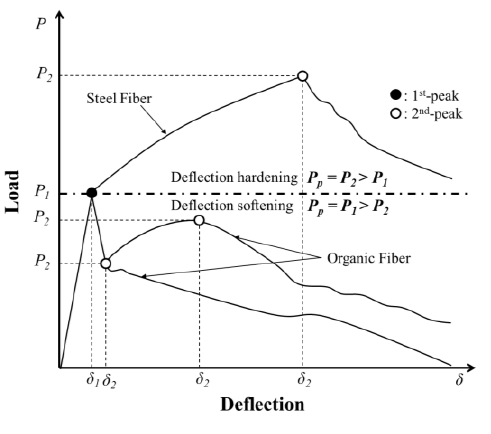
Figure 8. Typical load-deflection response of